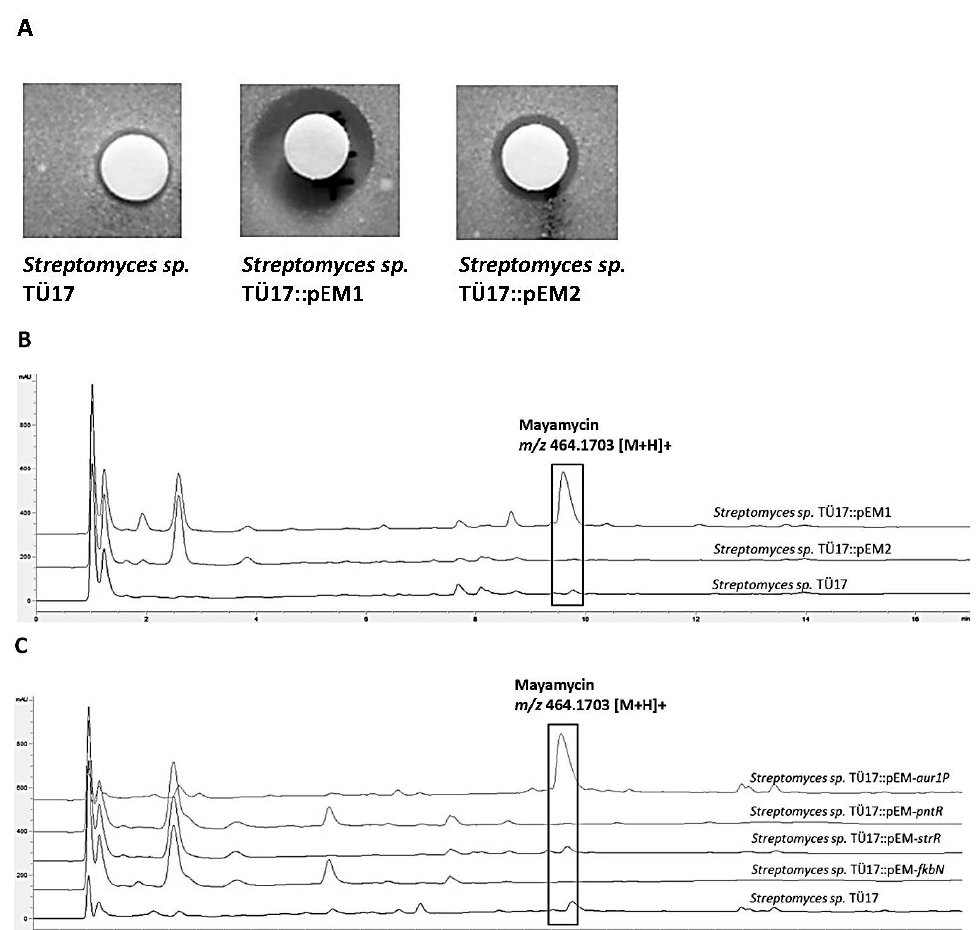
Figure 2. Analyses of the extracts of S. sp. TÜ17 wild type and recombinant strains. ( A ) Bioassay analysis of S. sp. TÜ17 and the recombinant strains S. sp. TÜ17::pEM1, S. sp. TÜ17::pEM2. Indicator strain Bacillus subtilis ; 10 µ L of the extracts were spotted of each culture on filter disc (1 mL ethylacetate extract was evaporated and dissolved in 100 µ L methanol). Inhibition zone of S. sp. TÜ17::pEM1 ø 1.2 cm. ( B ) HPLC/MS analysis of S. sp. TÜ17 and the recombinant strains S. sp. TÜ17::pEM1, S. sp. TÜ17::pEM2. A peak with m/z 464.1703 [M+H] + , corresponding to mayamycin, was only detected